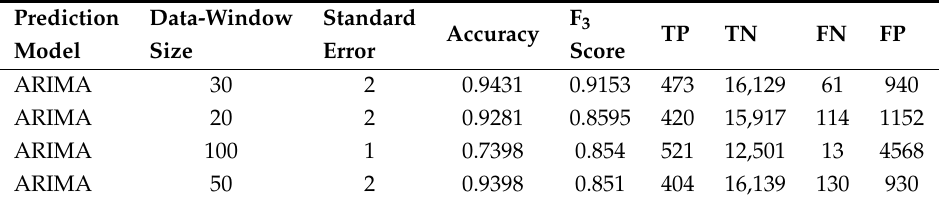
Table 3. Ranking with the first 4 positions of the results in Exp2, ordered by F 3 -Score.